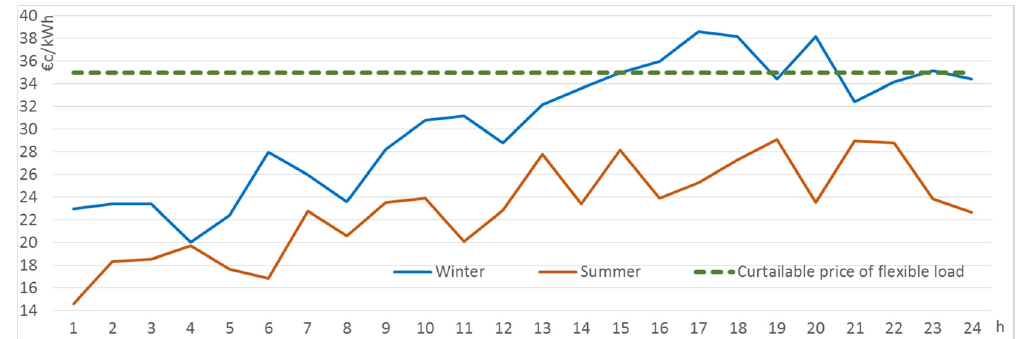
Figure 7. Twenty-four-hours dynamic distribution grid (DG) electricity price (winter and summer cases), curtailable price of the flexible SCM load.